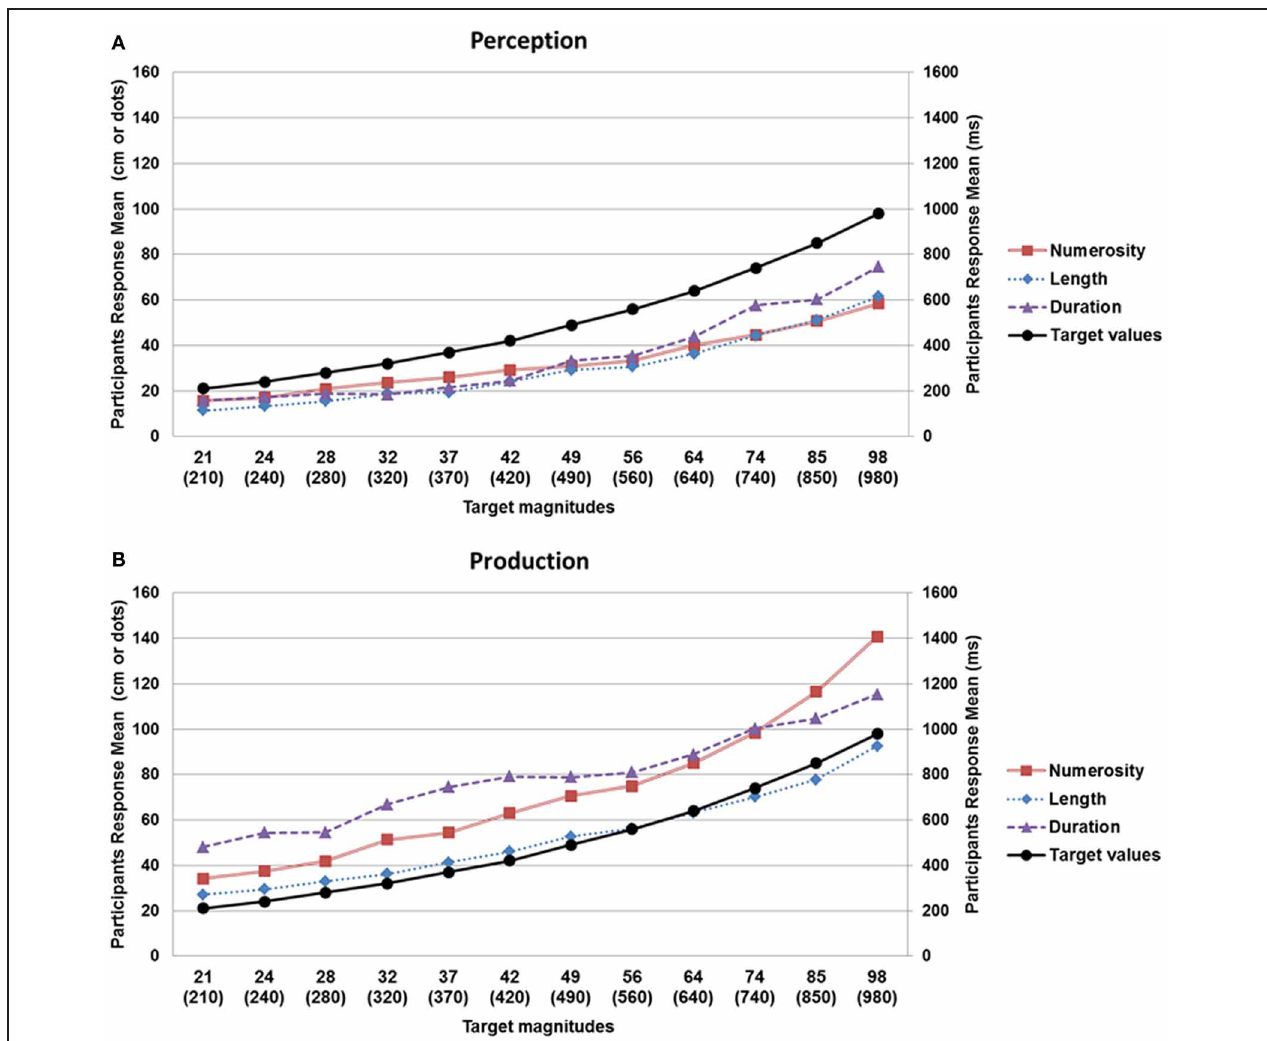
FIGURE 2 | Mean estimation values observed in the perception (A) and production (B) tasks as a function of target value (black line: target values; red line: numerosity; blue line: lenght; mauve line: duration). The left vertical axis shows the estimated values for numerosity and length (in number of dots and cm, respectively) while the right axis corresponds to the values for duration (in ms). On the